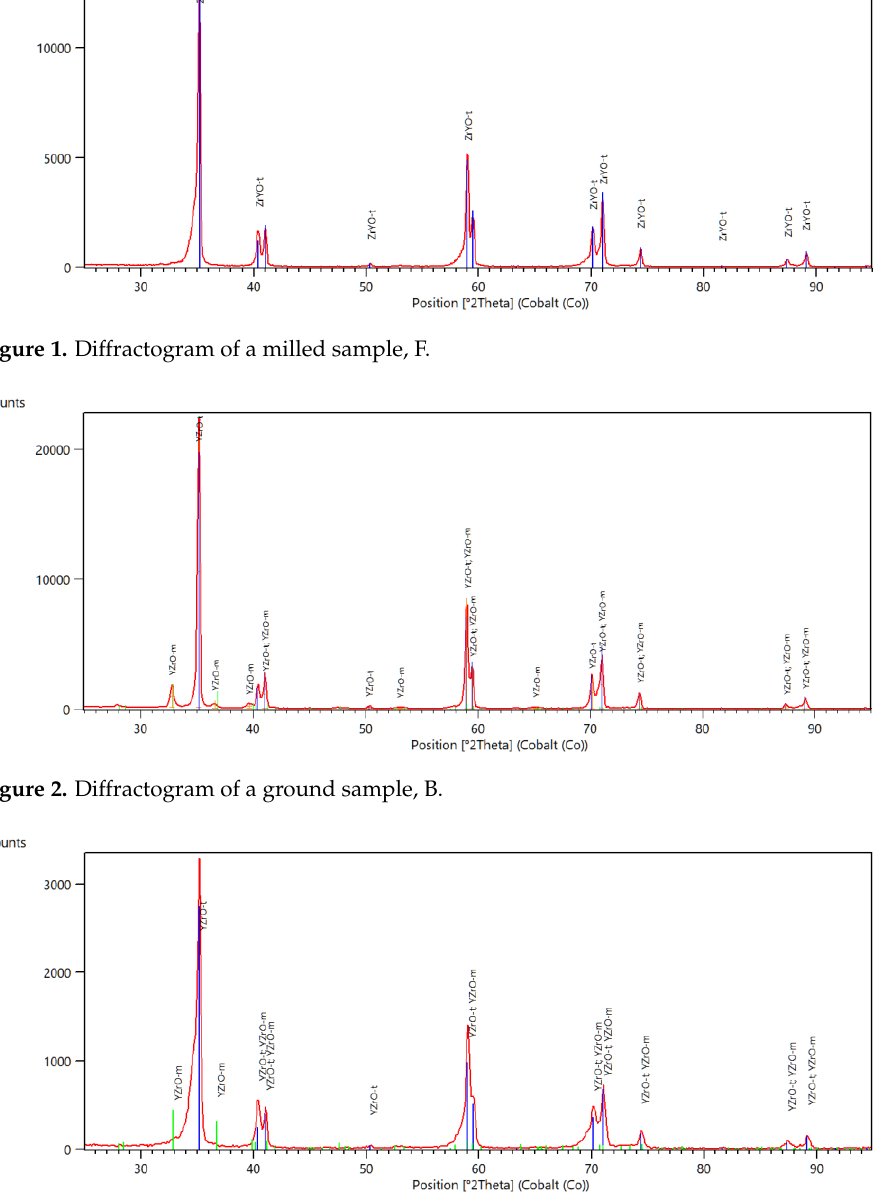
Figure 3. Diffractogram of a polished sample, E.